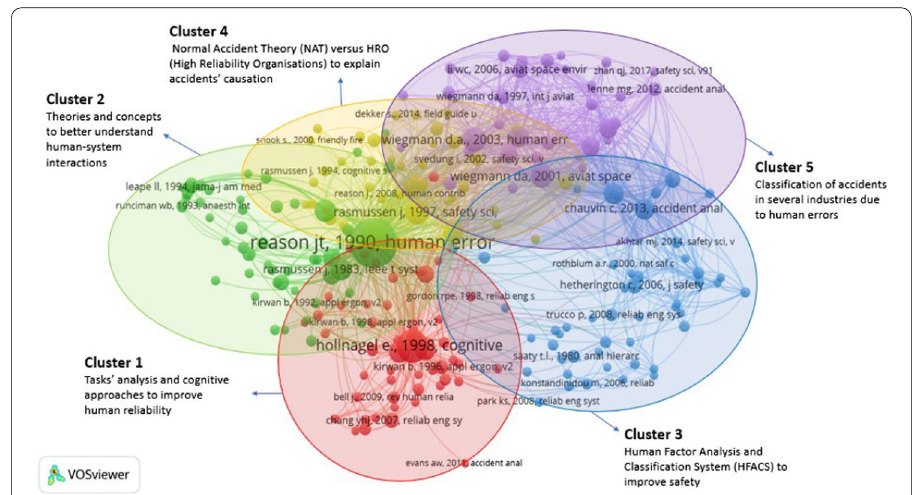
Fig. 3 CCA clusters based on keywords “Accidents